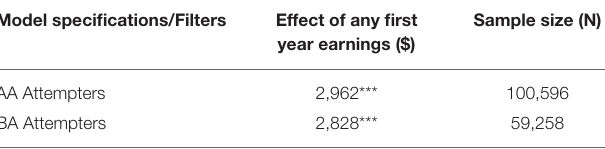
TABLE 7 | Effects of work during the first year of college on undergraduates’ later TABLE 6 | Effects of duration of employment on undergraduates’ post-college earnings, Augmented inverse probability weighting (AIPW) treatment effects earnings in dollars ($). Ordinary least squares regressions—full models. AA Attempters